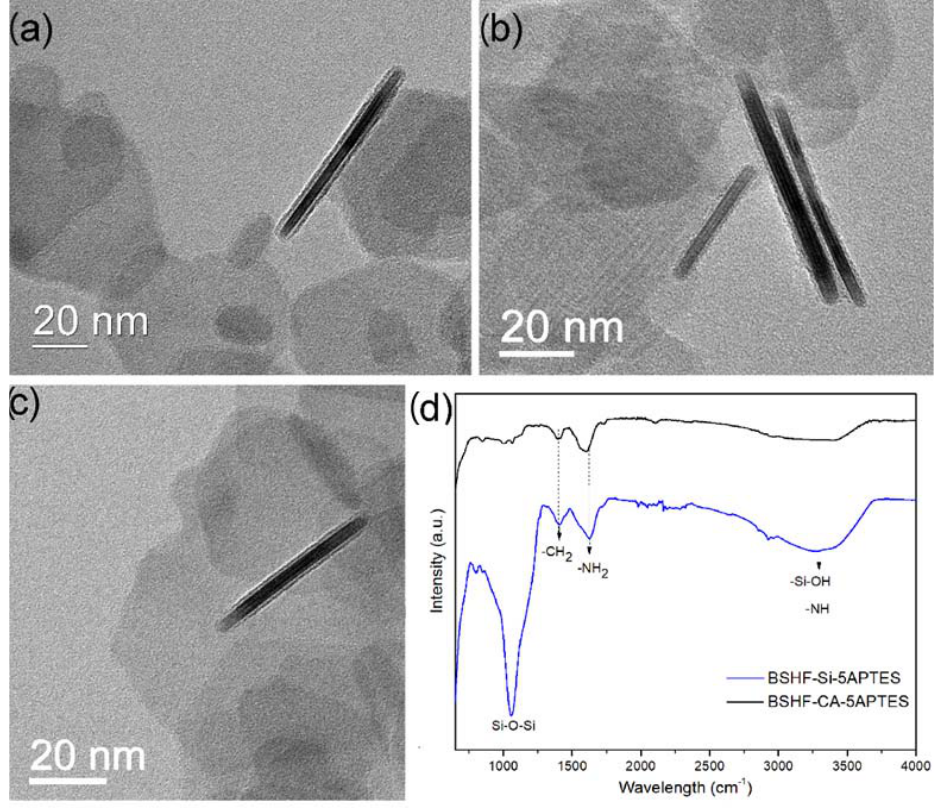
Figure 2. TEM images of ( a ) BSHF-Si; ( b ) BSHF-Si-5APTES; ( c ) BSHF-CA-5APTES NPLs; ( d ) FTIR spectra of samples BSHF-Si-5APTES and BSHF-CA-5APTES.